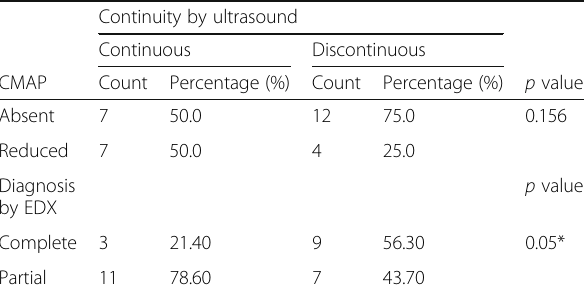
Table 6 CMAP amplitude and continuity of the injured nerve by ultrasound